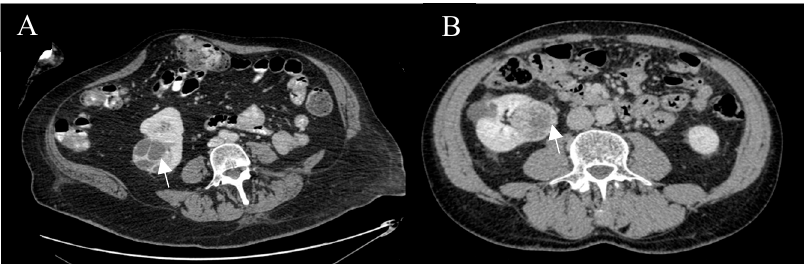
Figure 6. Post-contrast axial CT images of complex right renal cysts. ( A ) Bosniak IV cyst, conventional clear cell, pt3a, grade 2, resected by radical nephrectomy. ( B ) Bosniak IV cyst, oncocytoma, resected by partial nephrectomy.